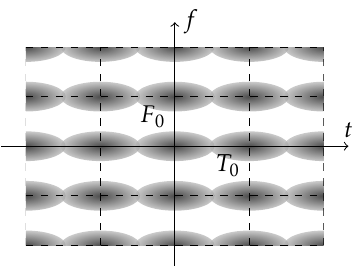
Figure 1. Representationof a transmittedsignal in the time- frequencyplane.Here,the generator g andthe parametersof the lattice allowfora separationin the frequencydomain,but notin the